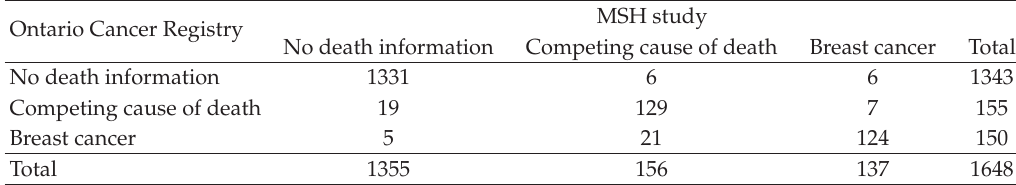
Table 3: Data for example 1.